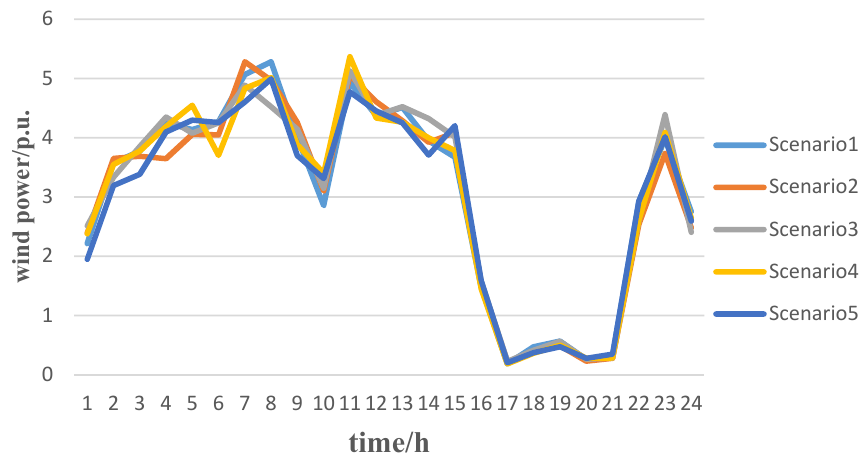
Figure 7. New wind power data containing five scenarios.